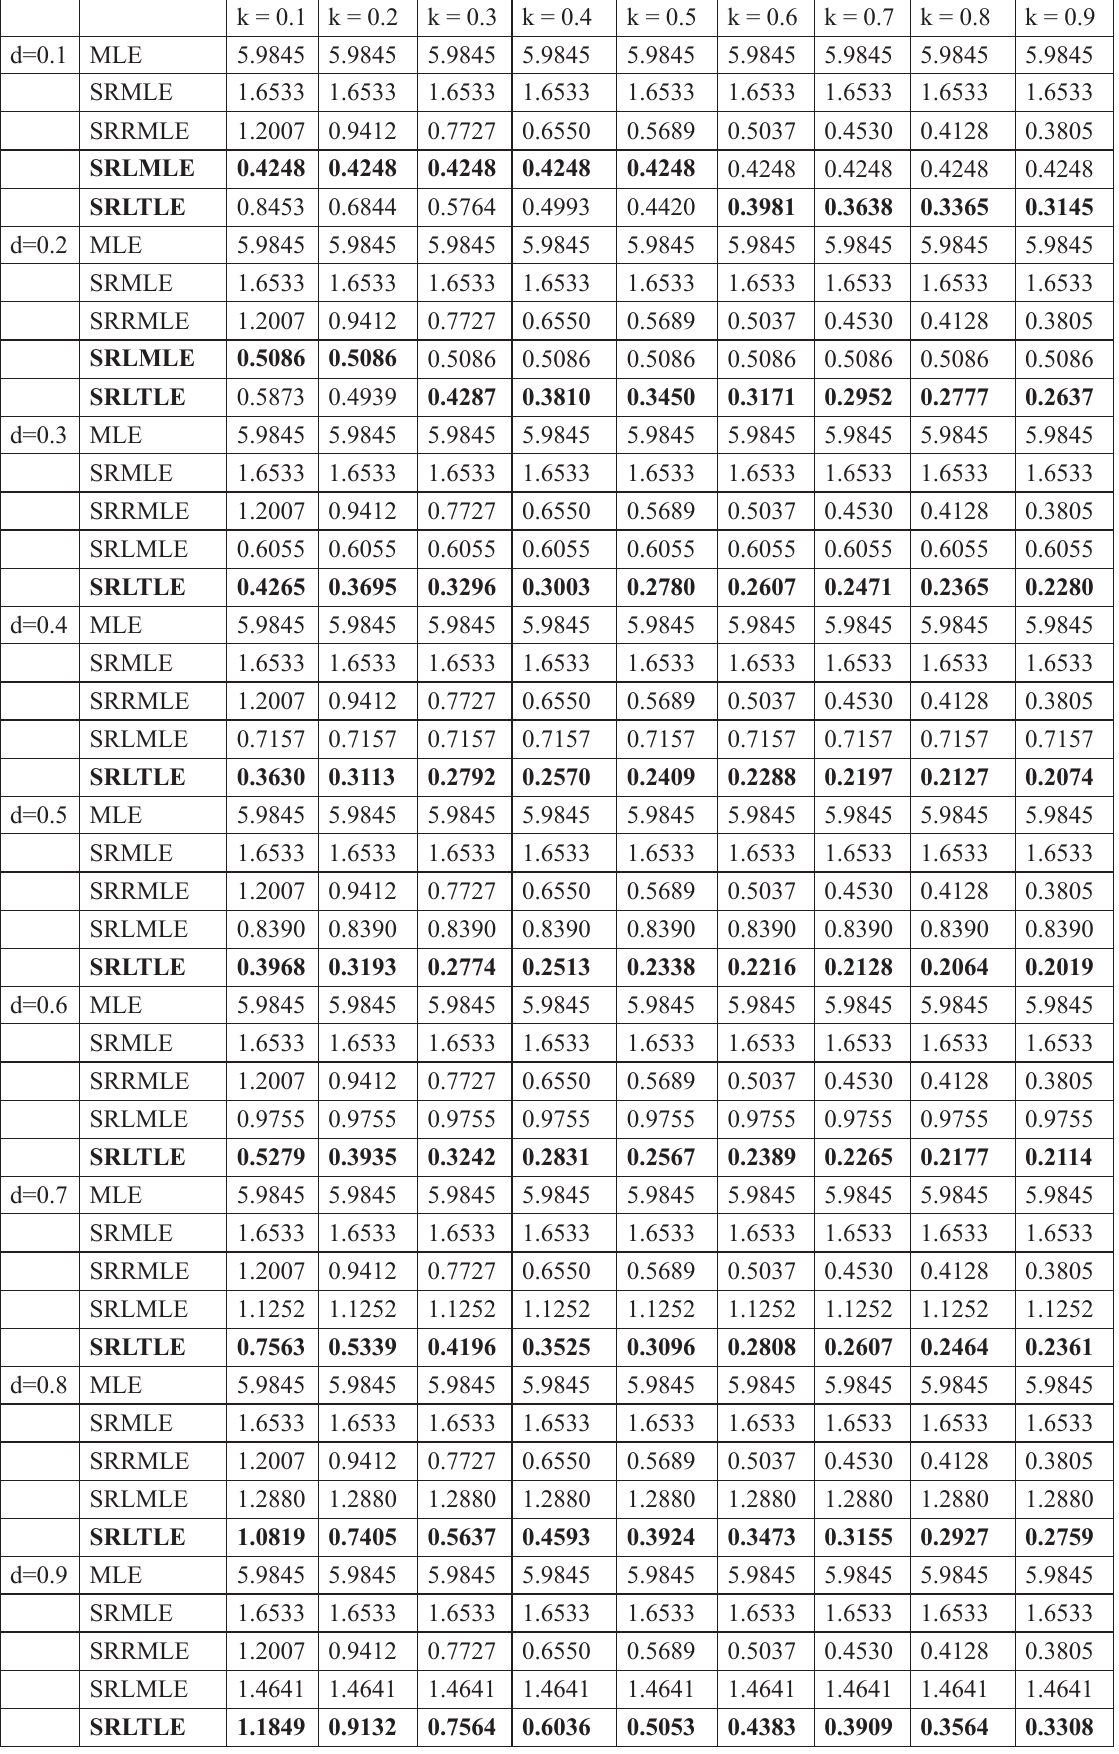
Table A6: The estimated MSE values for different k,d when n =15, and 0.99=